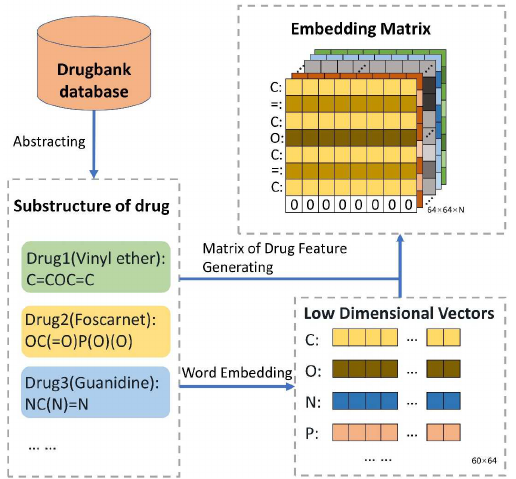
Figure 2. The guideline for extracting features of chemical sequence. The SMILES of all drugs were obtained from DrugBank. Additionally, vector representation, the matrix of 60 × 64, of all 60 biolog- ical symbols is learned by word2vec. Then, the SMILES of each drug corresponds to its own sym- bolic vector representation. Finally, N drugs can be indicated as N matrixes. To ensure the identical scale of the drug matrix, the strategies were adopted as follows: a. If the sequence length of the drug is shorter than 64, the vector of zero is attached to the drug matrix; b. If the sequence length of the drug is longer than 64, it is reduced to 64. 2.4. Network Structural Information The network structural information is a crucial character for potential interaction analysis and prediction. Under the entire drug network, each node can be represented by the structural relationship of nodes. In this subsection, we focus on the task of extracting the embedding vector-containing node structural information. The node structure is more similar, and the embedding vectors of the nodes are closer to each other. To fully utilize the network relation of DDIs and to globally express the straight or potential information